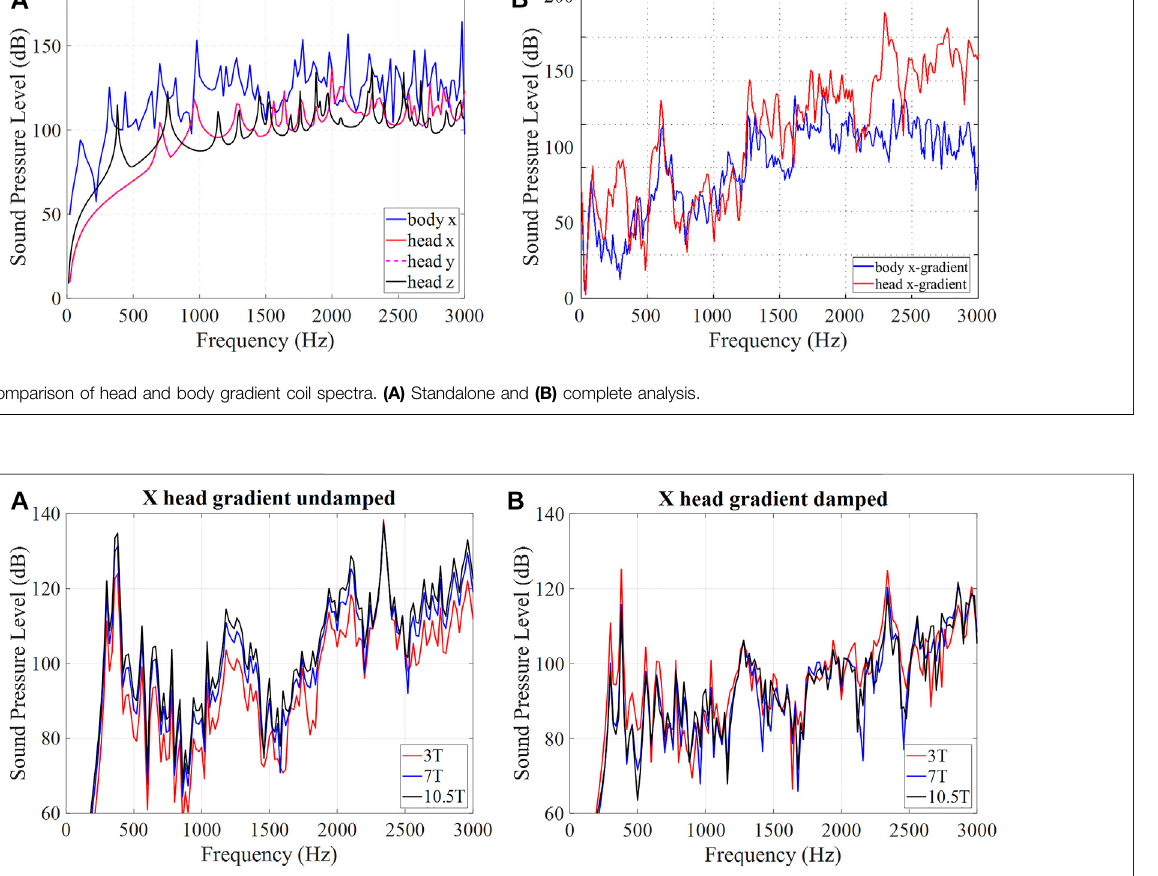
FIGURE 5 | SPL spectra (A) without and (B) with Lorentz damping at different fi eld strengths.